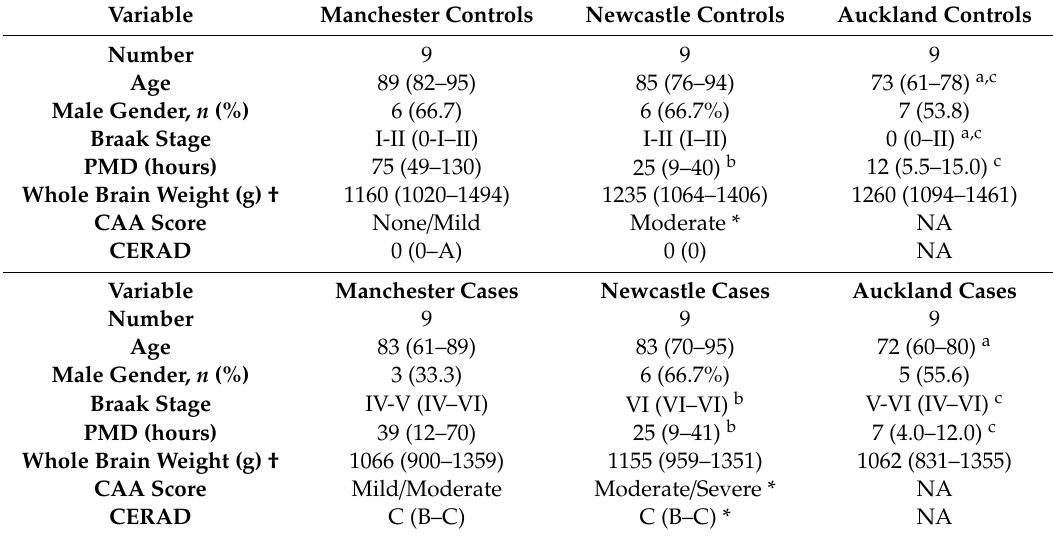
Table 1. Comparison of Brain Bank